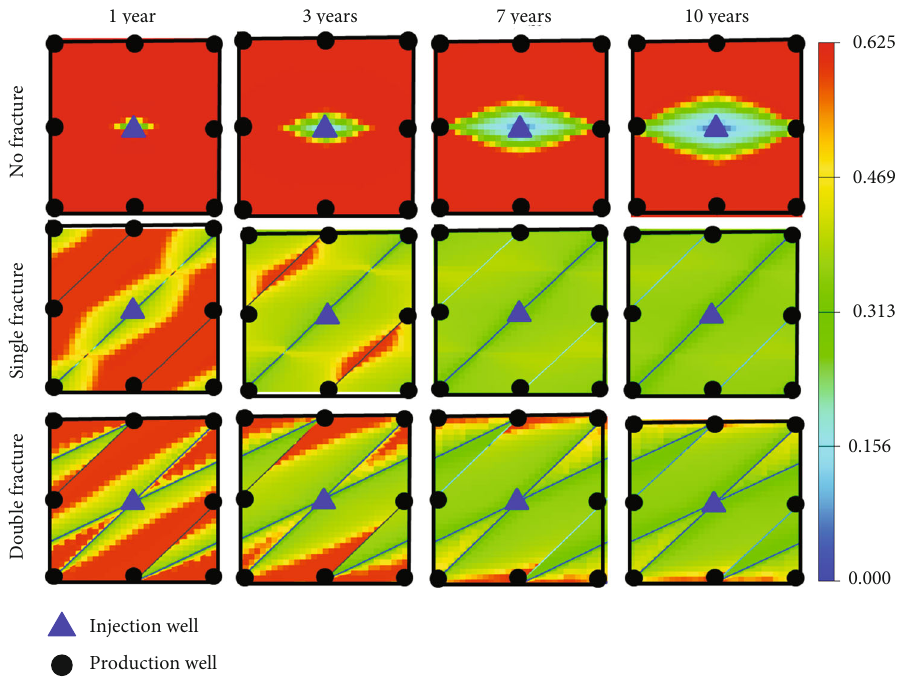
Figure 6: Planar distribution of the remaining oil saturation for di ff erent numbers of dynamic fractures and di ff erent times.